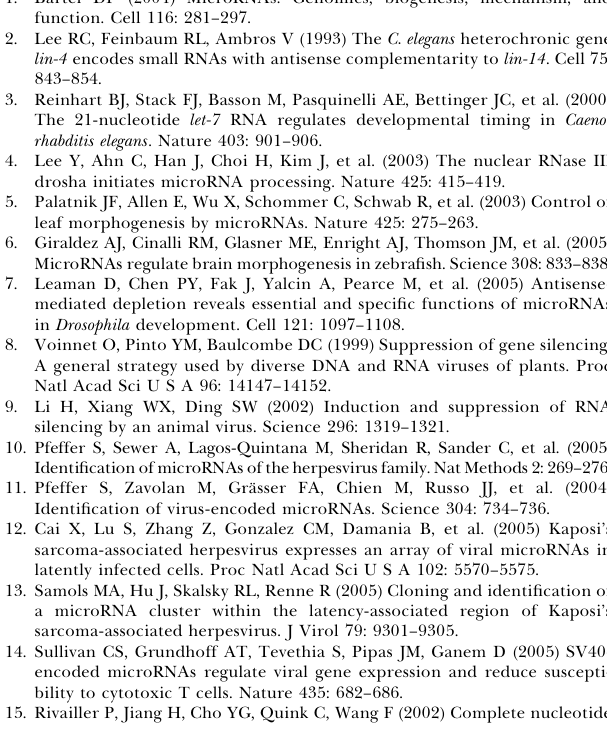
Figure S5. Predicted Primary miRNA Stem-Loop Structures for the Indicated rLCV miRNAs Mature viral miRNAs are indicated in red. Figure S6. Sequence Comparison of miR-BHRF1–2 miRNA and miR- rL1-2 Differences between the predicted miR-BHRF1–2 pri-miRNA stem- loop structure shown, and the predicted miR-rL1–2 sequence, are indicated. This rLCV miRNA is encoded 3 9 to the rLCV BHRF1 open reading frame, i.e., in the same genomic location as miR-BHRF1–2. Although it was not recovered during cDNA cloning (Table 2), it is detectable in rLCV-infected cells by Northern blot (Figure